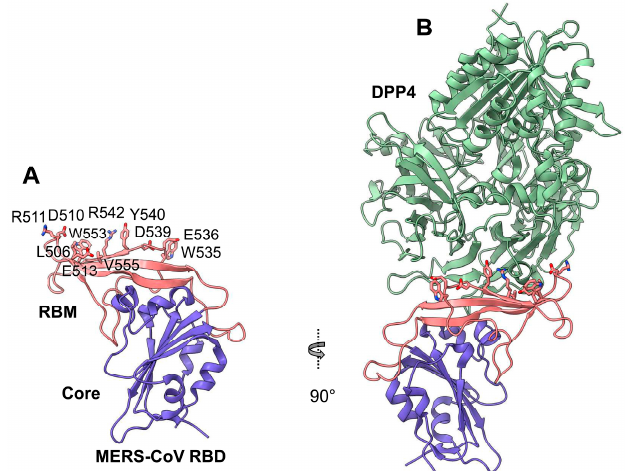
Figure 2. Structural basis of MERS-CoV S-protein RBD–DPP4 interaction. Structural data for the complex of MERS-CoV S-protein RBD bound to DPP4 are from the protein data bank (PDB) (ID: 4KR0). The MERS-CoV RBD core is colored in blue, the RBM is colored in red, and DPP4 is colored in green. The RBM residues directly involved in DPP4 binding are shown as sticks. DPP4, dipeptidyl peptidase 4; RBD, receptor-binding domain; RBM, receptor-binding motif; S, spike protein.